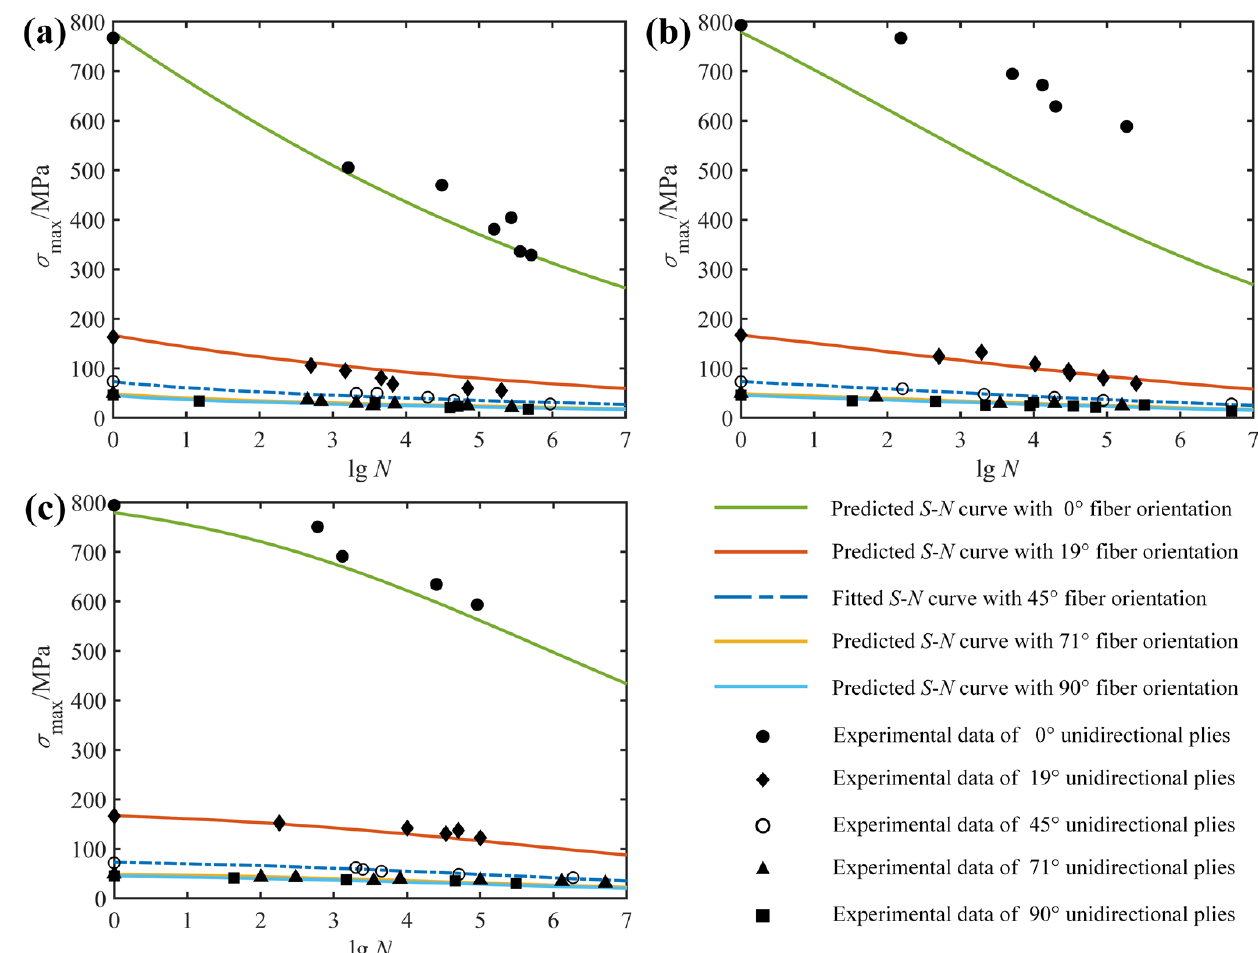
Figure 6. Fitted (45°) and predicted (other angles) S - N diagrams of unidirectional E-glass/epoxy specimens, together with experimental data from Ref. [32]: ( a ) R = − 1; ( b ) R = 0; ( c ) R = 0.5.